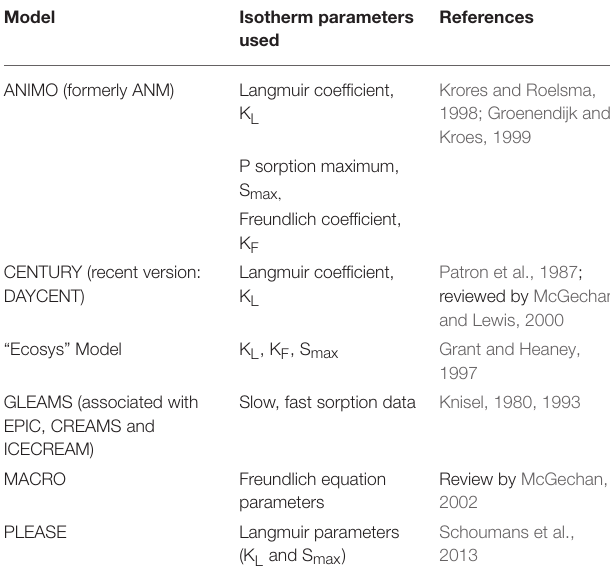
TABLE 1 | Isotherm parameters used in various mechanistic phosphorus loss